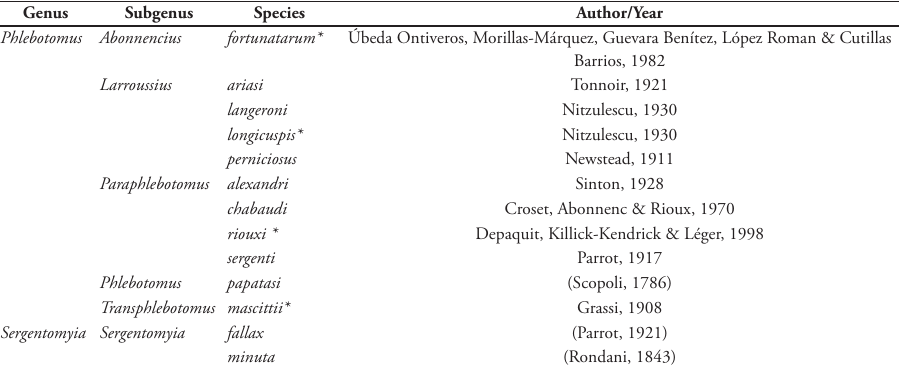
Table 1. Checklist of sand flies species recorded in Spain, classified by genus and